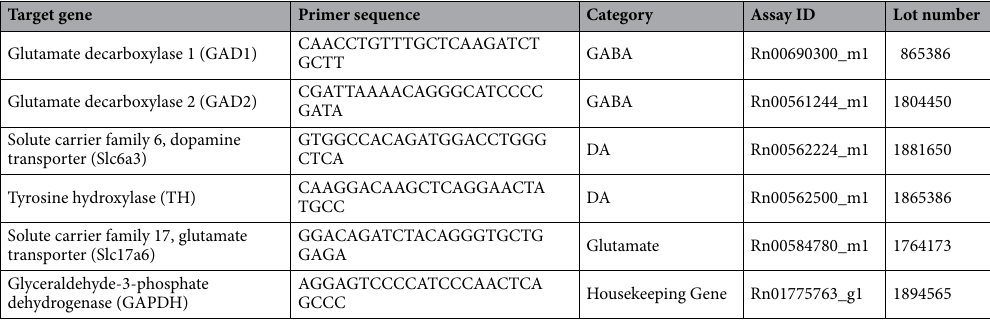
Table 1. List of primer sequences for GABA, DA, and glutamate neural markers.